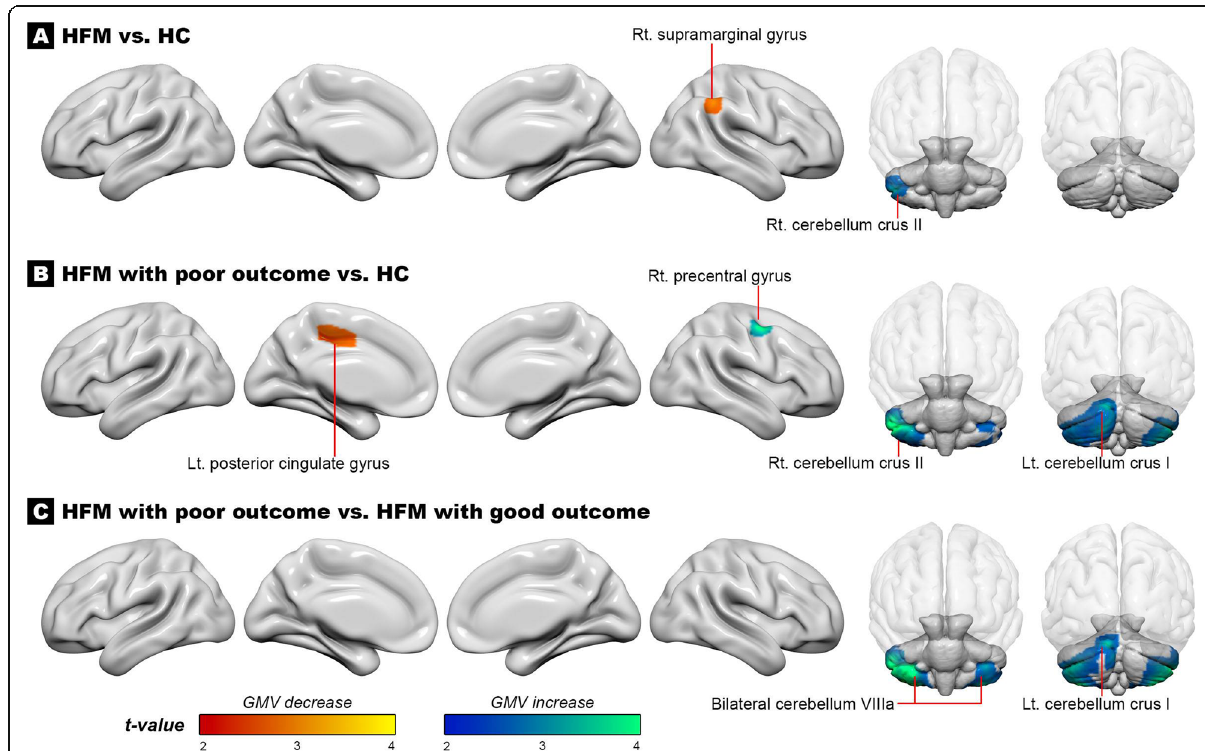
Fig. 1 The red and blue markers are regions of different gray matter volume ( a ) between patients with high-frequency migraine (HFM) and healthy controls (HC); ( b ) between patients with poor outcome and HC; ( c ) between patients with different outcomes